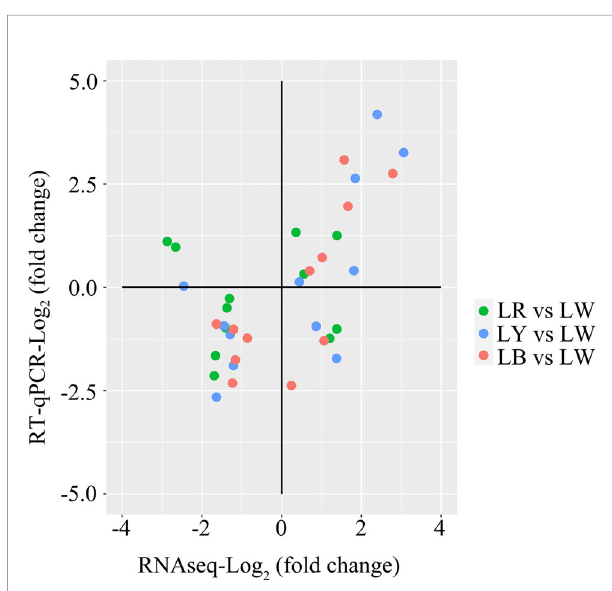
FIGURE 6 | Correlation between RNA-seq and RT-qPCR determination of gene expression ( r = 0.569, p < 0.0001). Green, comparisons between LR and LW (LR vs. LW). Blue, comparisons between LY and LW (LY vs. LW). Red, comparisons between LB and LW (LB vs. LW). LR, red light; LW, full- spectrum light; LY, yellow light; LB, blue